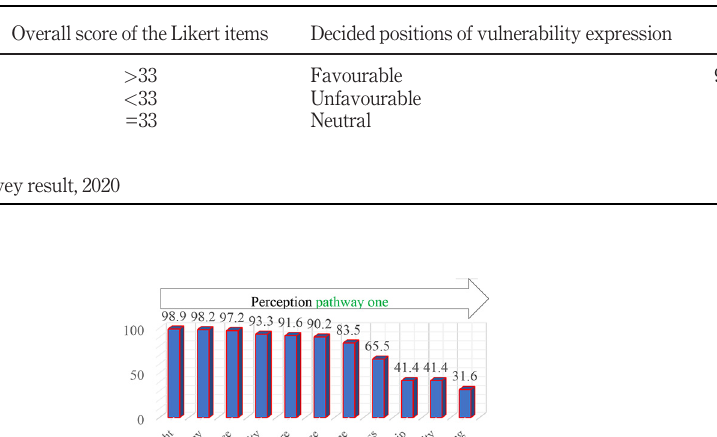
Figure 2. Schematic pathways